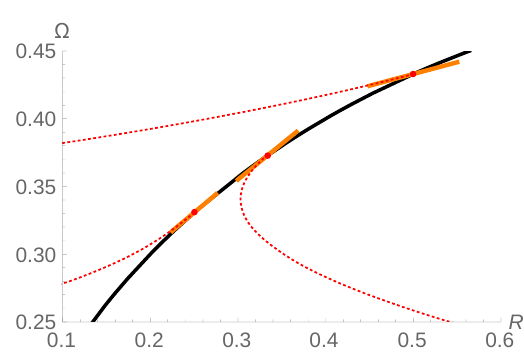
Figure 8 . Beginning of the branches for ( N; m ) = (0 ; 4), (1 ; 4) and (1 ; 6) on the ( R 0 ; (cid:10)) plane.